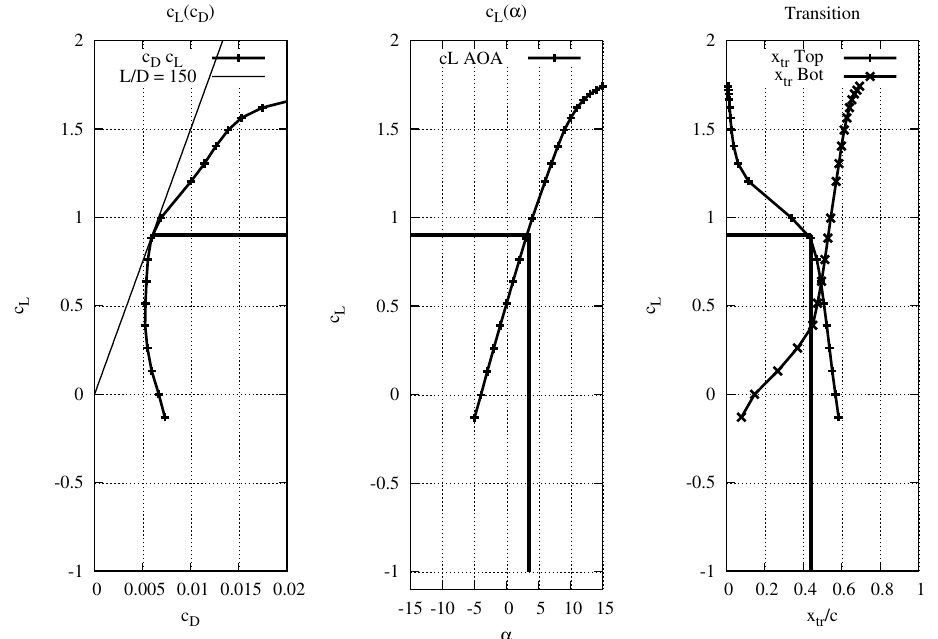
Figure 1. Determination of operating point for aerodynamic profile. See Table 1 for numbers and Figure 2 for an outline of the shape.